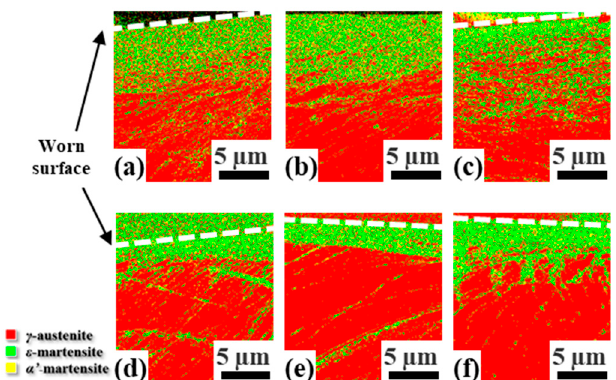
Figure 7. EBSD analysis of cross-sectioned SUS304 blocks after wear tests: phase maps (PM) of blocks at rotation speeds of ( a ) 100, ( b ) 200, and ( c ) 300 rpm obtained from tests under dry conditions and rotation speeds of ( d ) 100, ( e ) 200, and ( f ) 300 rpm obtained from tests under wet conditions.